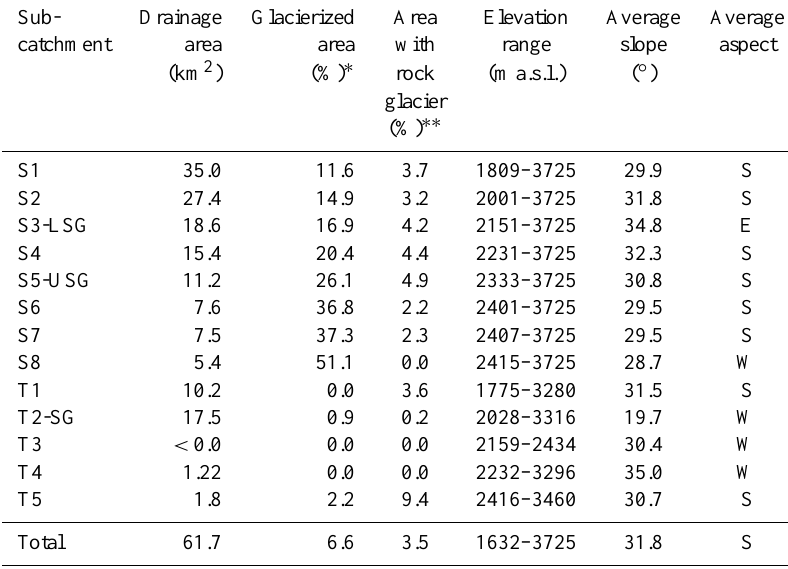
Table 1. Main morphometric properties of the sub-catchments considered in the study area. Sub- Drainage Glacierized Area Elevation Average Average catchment area area with range slope aspect (km 2 ) (%) ∗ rock (ma.s.l.) ( ◦ ) glacier (%) ∗∗ S1 35.0 11.6